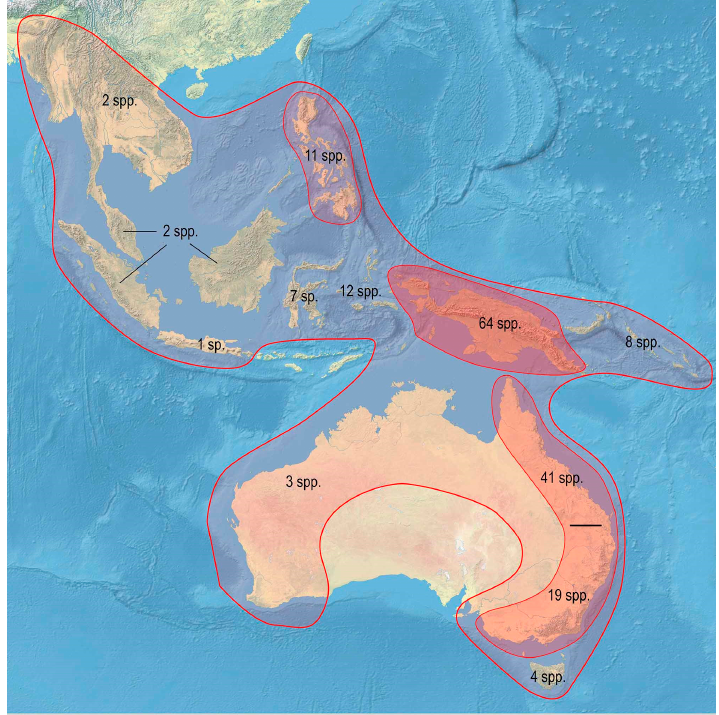
Figure 5. Distribution and diversity of Metriorrhynchus Gemminger & Harold, 1869.